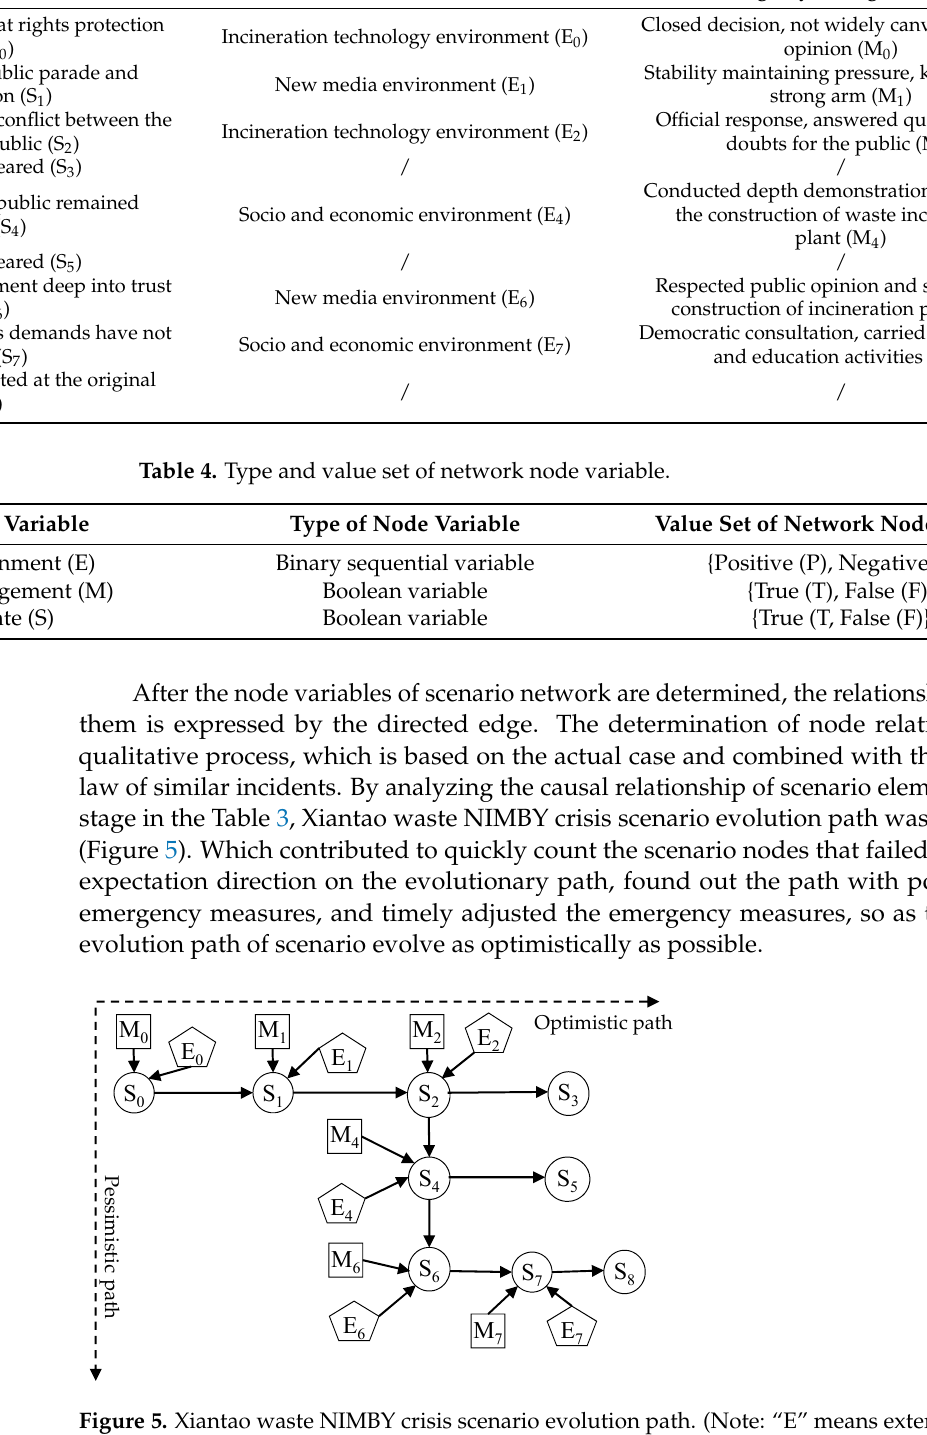
Table 5. Detailed scoring rules of network nodes.